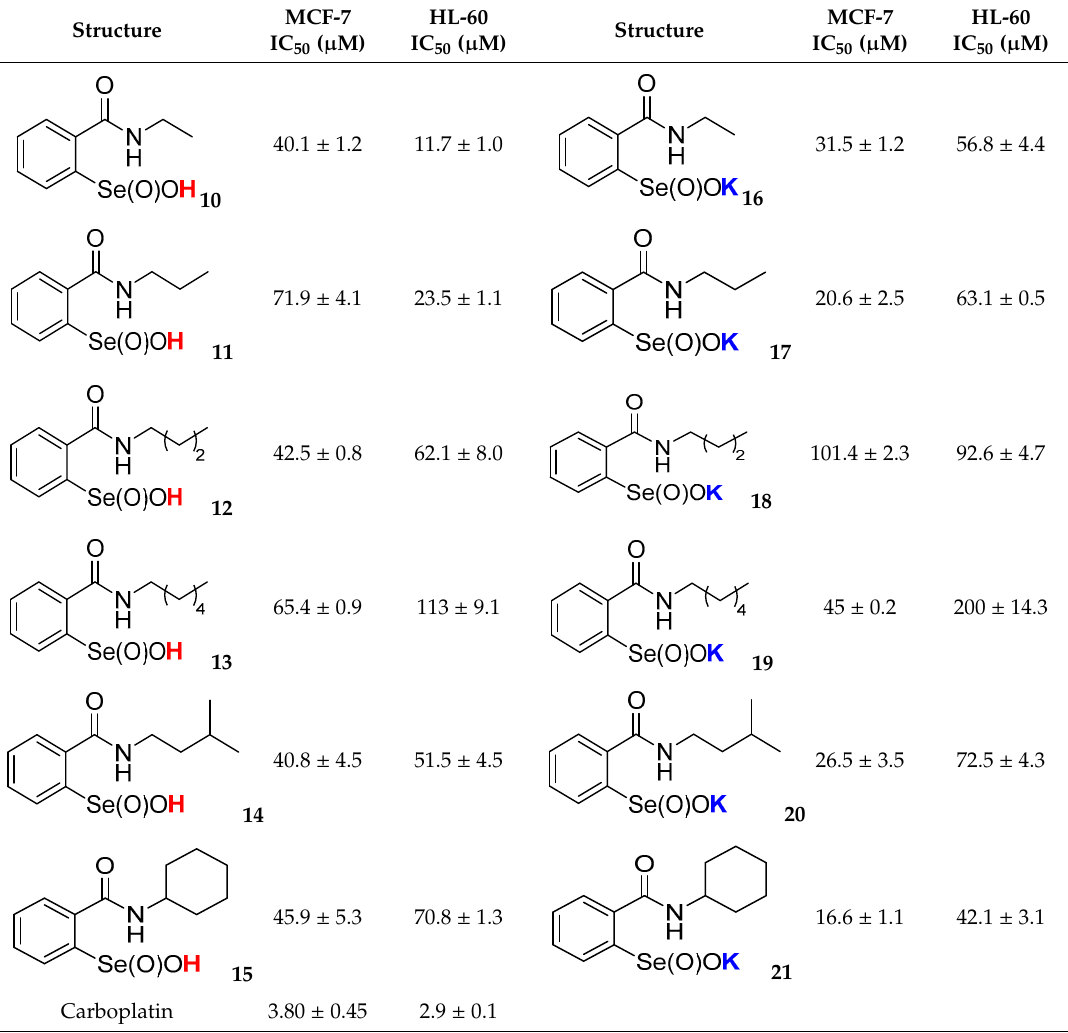
Table 4. Cytotoxic activity of acids 1–14 and corresponding salts 16–20. Structure